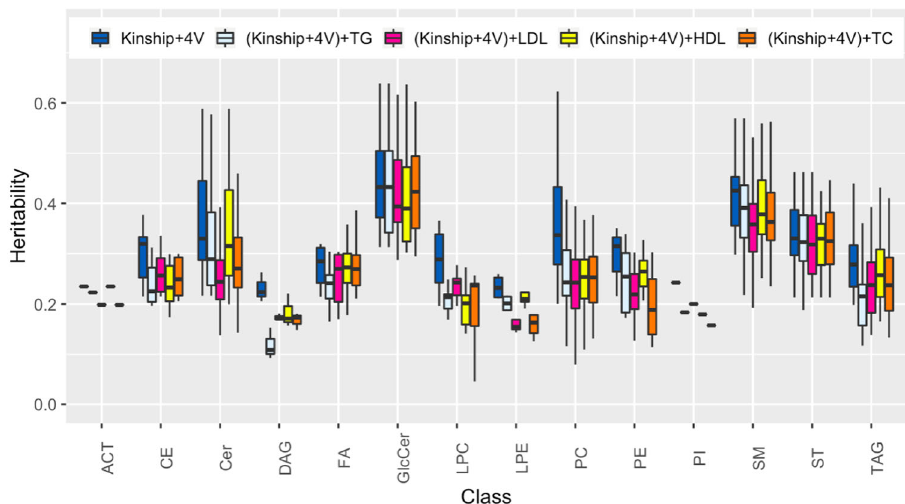
Fig. 2 Contribution of previously identi fi ed lipid GWAS variants to lpidomics variance. Heritability estimates using adjusted kinship separately (Adjusted for 4 Amish-enriched lipid variants ( APOB _rs5742904 15 , APOC3 _rs76353203 14 , B4GALT1 _rs551564683 21 , TIMD4 _rs898956003 20 ) and then jointly with a SNP GRM for each traditional lipid. Analysis restricted to 194 lipid species with baseline signi fi cant heritability (Kinship + 4V heritability p -value < 0.01). The upper, center, and lower line of the boxplot indicates third quartile (Q3), median, fi rst quartile (Q1), respectively. The upper and lower whisker of the boxplot indicates Q3 + 1.5 * interquartile range (IQR) and Q1 − 1.5 * IQR. Outliers are suppressed from the plot for readability. ACT Acylcarnitine, CE Cholesteryl ester, Cer Ceramide, DAG Diglycerides, FA Fatty acids, GlcCer Glycosphingolipids, LPC Lysophosphatidylcholines, LPE Lysophosphatidylethanolamines, PC Phosphatidylcholines, PE Phosphatidylethanolamine, PI Phosphatidylinositol, SM Sphingomyelin, TAG Triglycerides, ST